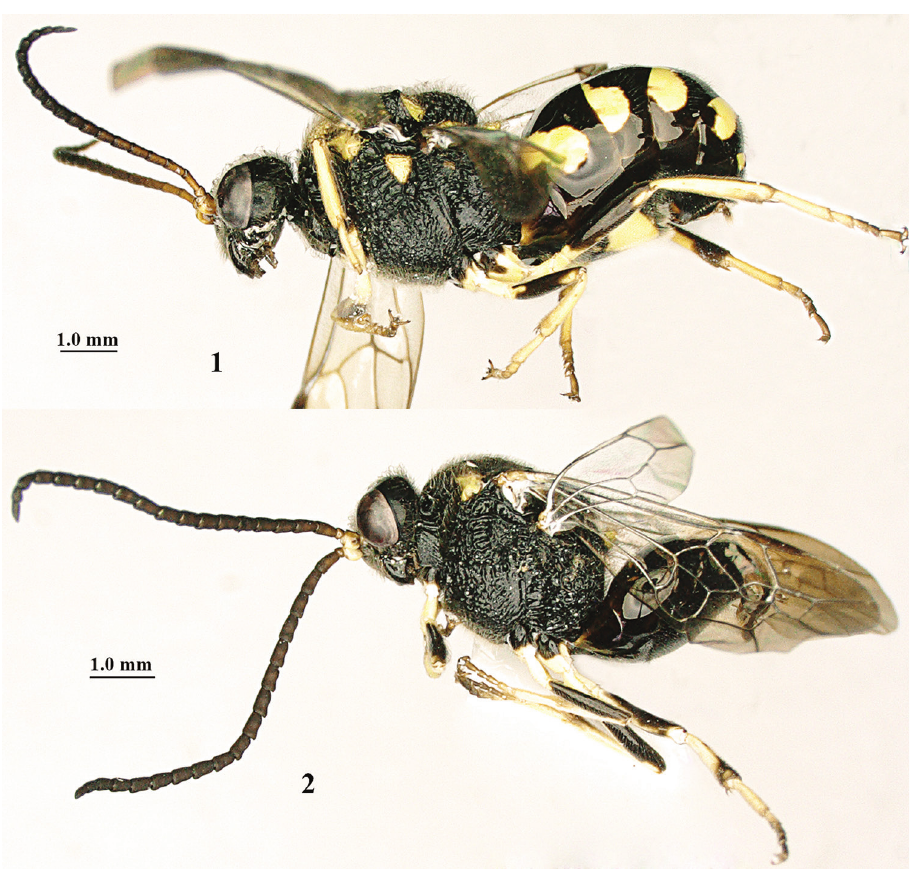
Figures 1, 2. Bareogonalos xibeidai sp. n. 1 female holotype, habitus lateral 2 male paratype, habitus lateral.